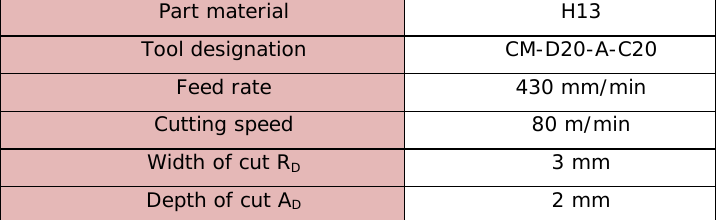
Table 1. “Cutting parameters”. Source: